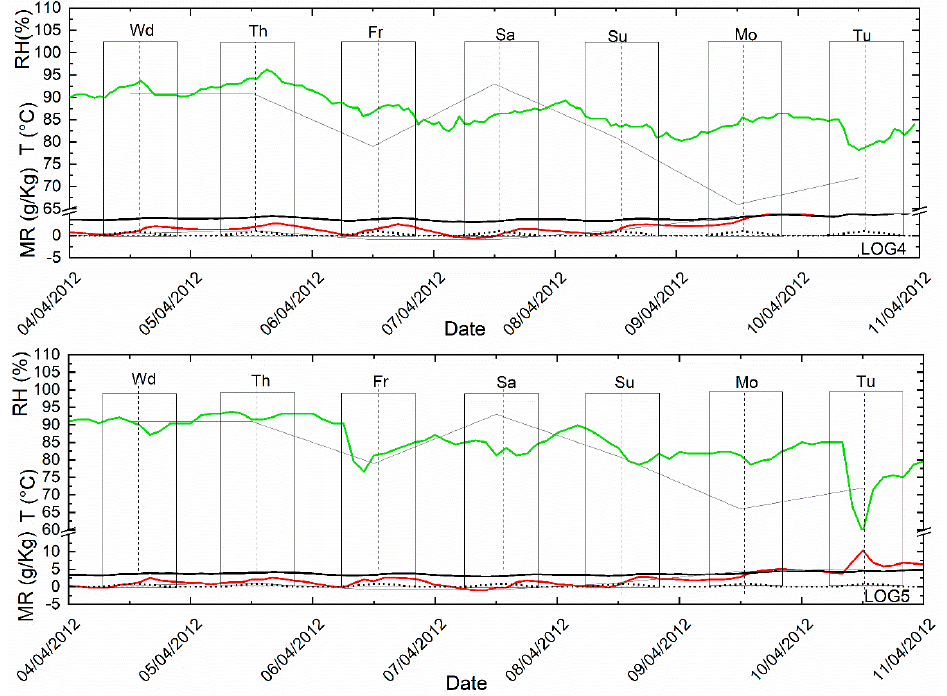
Figure 13. Indoor RH (%)-green line, T ( ◦ C)-red line, MR (g / Kg)-black line values for Easter week representative of microclimate conditions and churchgoers’ presence in spring as measured by Log4 (top plot) and Log5 (bottom plot). The grey line refers to outdoor RH values collected by the Kristiansund lufthavn weather station. Daylight duration is highlighted by rectangular